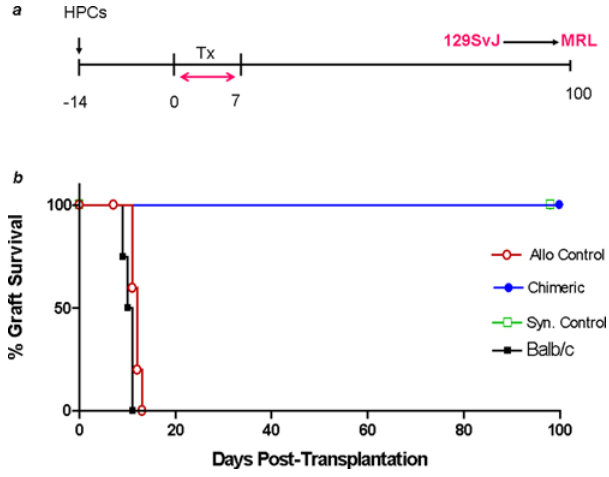
Figure 4. ES-derived HOXB4-expressing HPCs induce immuno- logical tolerance to donor type cardiac allografts. A) Treatment protocol: MRL recipient mice were transplanted HPCs 14 days prior to transplantation of cardiac allografts which was performed between days 0 and 7. Cardiac function and survival were monitored by daily abdominal palpations. B) Graft survival: Chimeric MRL recipient mice tolerated donor type cardiac allografts, but not Balb/c third party allografts. Non-chimeric MRL mice acutely rejected allografts within 13 days. Syngeneic grafts were additionally used as controls.